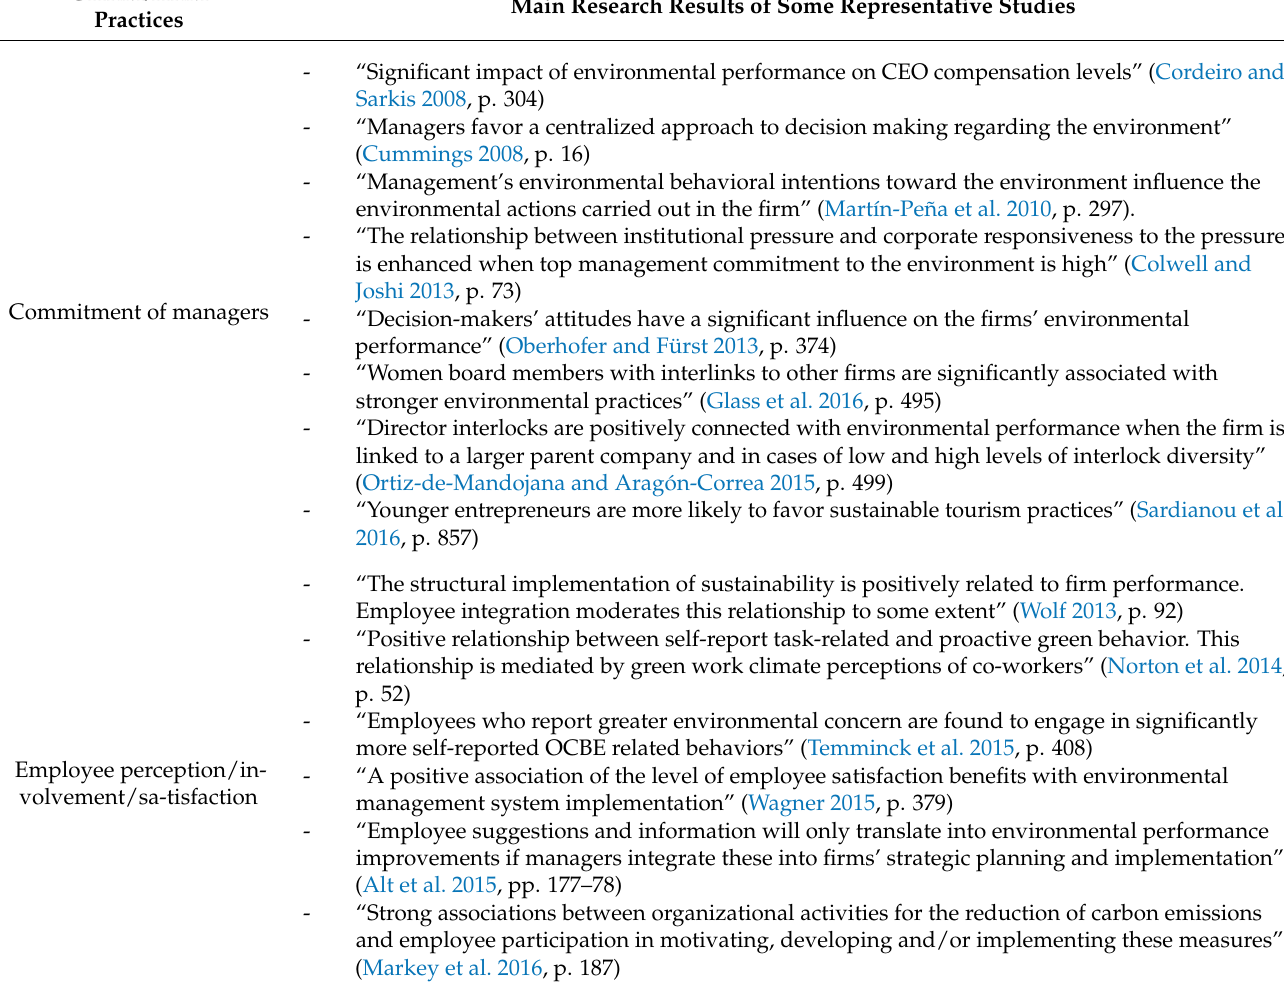
Table 2. Examples of HRM/GHRM